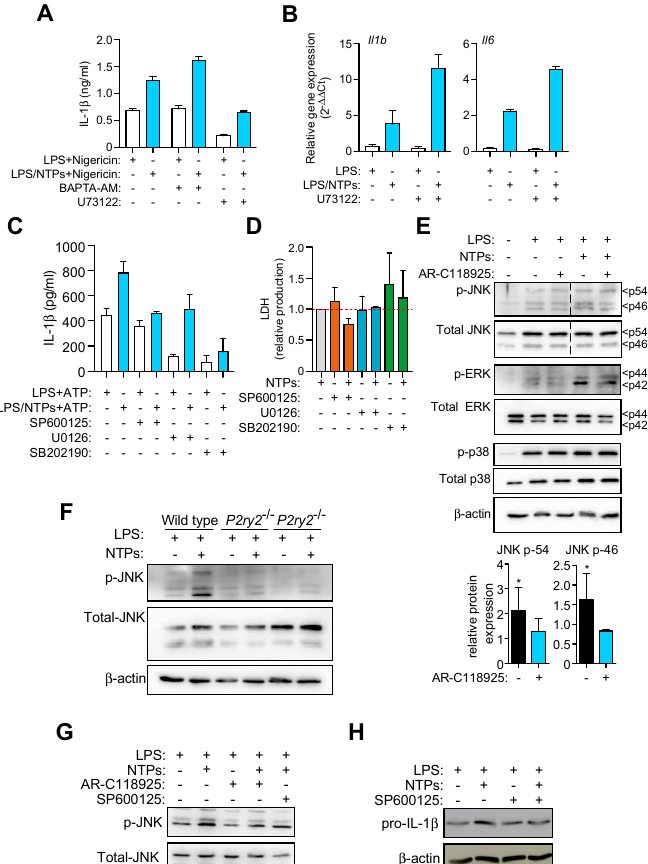
Figure 5. Nucleotides induce an increase in MAPK JNK activity to enhance IL-1 β production. ( A ) IL-1 β ELISA in supernatants from resting peritoneal macrophages (RPMs) pretreated with BAPTA-AM at 13 µ M or the PLC inhibitor U73122 at 2.5 µ M for 20 min prior LPS priming with (blue bars) or without (white bars) NTPs (20 µ M UTP / ATP) and then NLRP3 was activated with nigericin. A representative experiment of five is shown with + SD. ( B ) Expression by qPCR analysis of Il1b and Il6 genes from mRNA extracted from RPMs preincubated or not with U73122 at 5 µ M for 20 min and then primed with LPS with or without NTPs (20 µ M UTP / ATP) for 2 h. Graph shows one experiment of two represented as relative gene expression normalized to Hprt1 expression + SD. ( C ) IL-1 β ELISA from peritoneal macrophages (RPMs) supernatants pretreated or not with the indicated JNK, ERK1 / 2, or p38 (SP600125, U0126, or SB202190 respectively) inhibitor for 20 min prior LPS priming with (blue bars) or without (white bars) nucleotides (NTPs: 20 µ M UTP / ATP) for 3 h following NLRP3 activation with 3 mM ATP. One representative experiment out of 3 is shown + SD. ( D ) Extracellular LDH as a marker of cell death from RPMs treated with SP600125, U0126 or SB202190, in the presence or absence of NTPs. Average of four (SP600125) or two (U0126, SB202190) experiments + SEM is shown. ( E ) Lysates from RPMs pretreated with AR-C118925xx inhibitor and stimulated for 25 min with LPS with NTPs (20 µ M UTP / ATP) were analyzed for MAPK levels by western blot (top). Dashed line indicates lanes were eliminated from the image to compose the final picture. One experiment out of 3 is shown. Quantification of band intensity of four experiments + SEM of phospho-JNK p-54 and p-46 normalized to total JNK is shown (bottom). ( F ) RPMs cell lysates from wild-type or P2ry2 − / − mice were analyzed by western blot for the indicated proteins; one experiment out of 2 is shown. ( G ) Lysates from RPMs pretreated with or without AR-C118925xx or SP600125 inhibitor for 20 min and then stimulated for 25 min with LPS or LPS + NTPs (20 µ M UTP / ATP) were analyzed for JNK protein levels by western blot. ( H ) Lysates from RPMs pretreated with or without SP600125 inhibitor for 20 min and then stimulated for 2 h with LPS or LPS + NTPs (20 µ M UTP / ATP) were analyzed for pro-IL-1 β and β -actin protein levels by western blot. * = p < 0.05